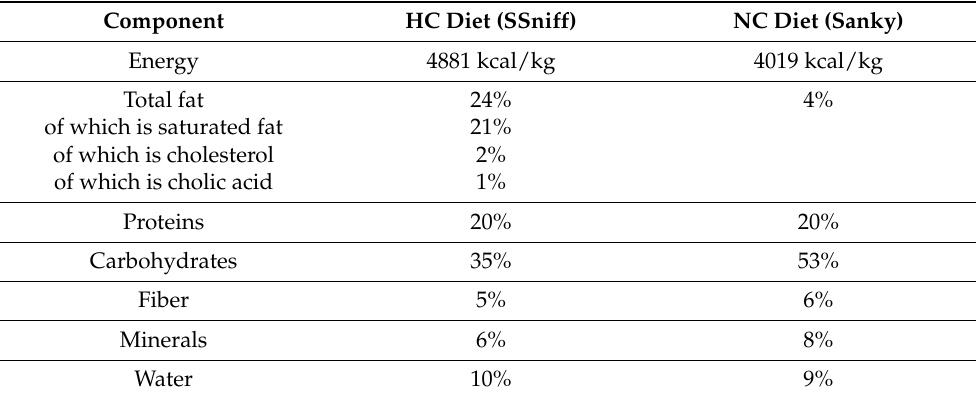
Table 2. Dietary composition of hypercholesterolemic and normocholesterolemic